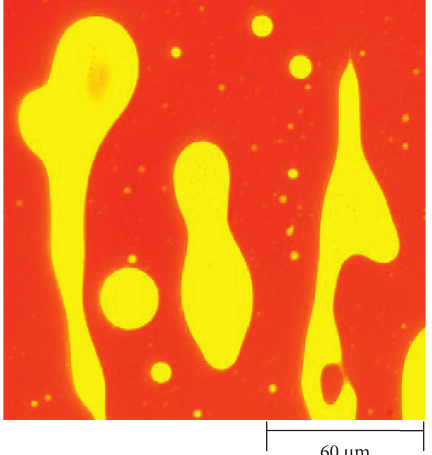
Figure 19: Fluorescence microscopic binarization image of complete development of SBS modified asphalt with 0% content of APR.